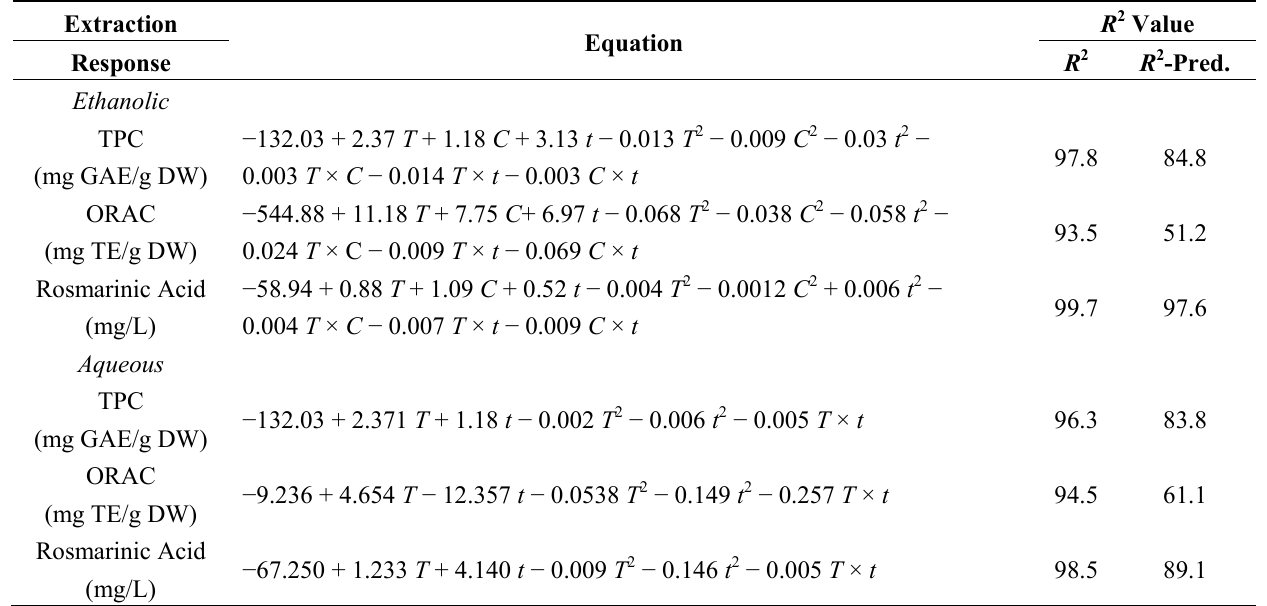
Table 4. Mathematical equations from response surface method (RSM) for each of the responses, with their respective value of R 2 and R 2